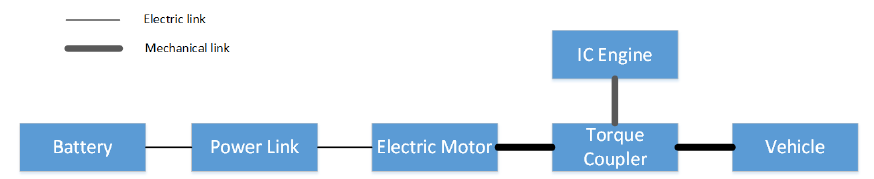
Figure 5. Parallel hybrid